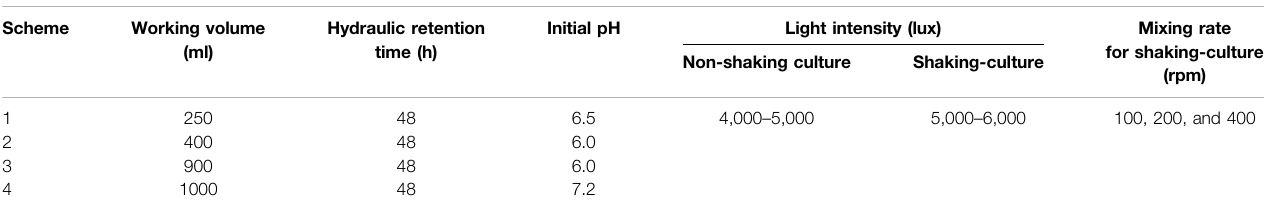
TABLE 1 | Schemes and varying